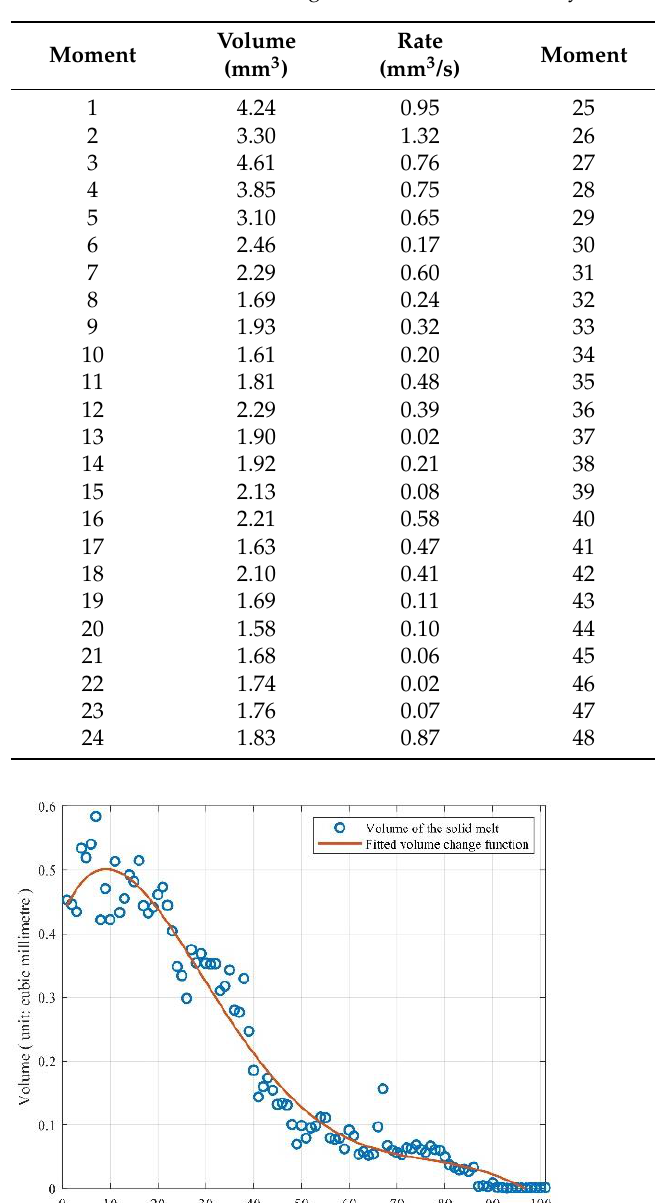
Figure 11. Original color image of silicon dioxide. Table 2. Table of actual melting rates of silicon dioxide by volume.